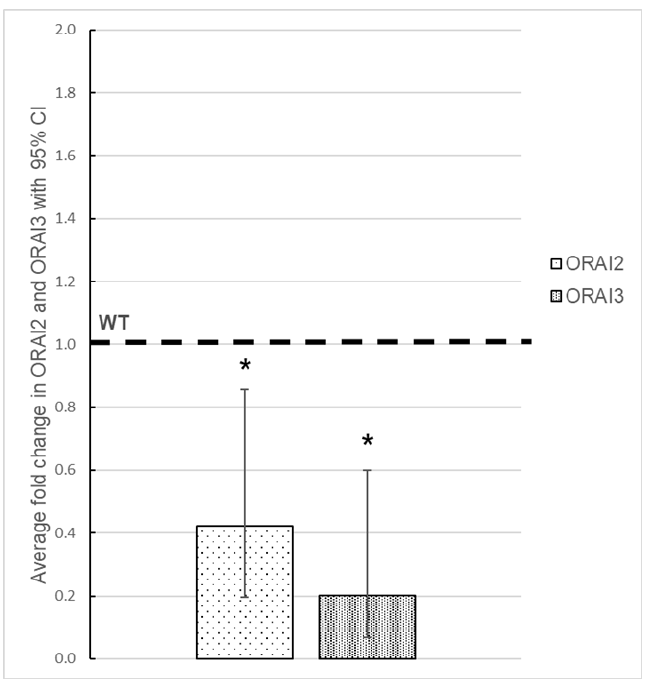
Figure 4. ORAI1 knockout (KO) leads to the downregulation of ORAI2 and ORAI3 messenger RNA (mRNA) expression. Dotted boxes represent the mean expression level of ORAI2 and ORAI3 mRNA measured by quantitative reverse-transcription polymerase chain reaction (RT-qPCR) from four independent experiments. The levels of ORAI2 and ORAI3 mRNA in wild-type (WT) HEK-293 cells were arbitrarily set at 1. In ORAI1 KO cells, ORAI2 (low-density dots, left box) and ORAI3 (high-density dots, right box) are downregulated ( ORAI2 relative mean expression level 0.42 with a 95% confidence interval [CI] of 0.19–0.87; ORAI3 relative mean expression level 0.20 with a 95% CI of 0.07–0.60 compared with WT. The significance of the results was assessed by unpaired t -test (* p = 0.02 for ORAI2 and * p = 0.01 for ORAI3 ).